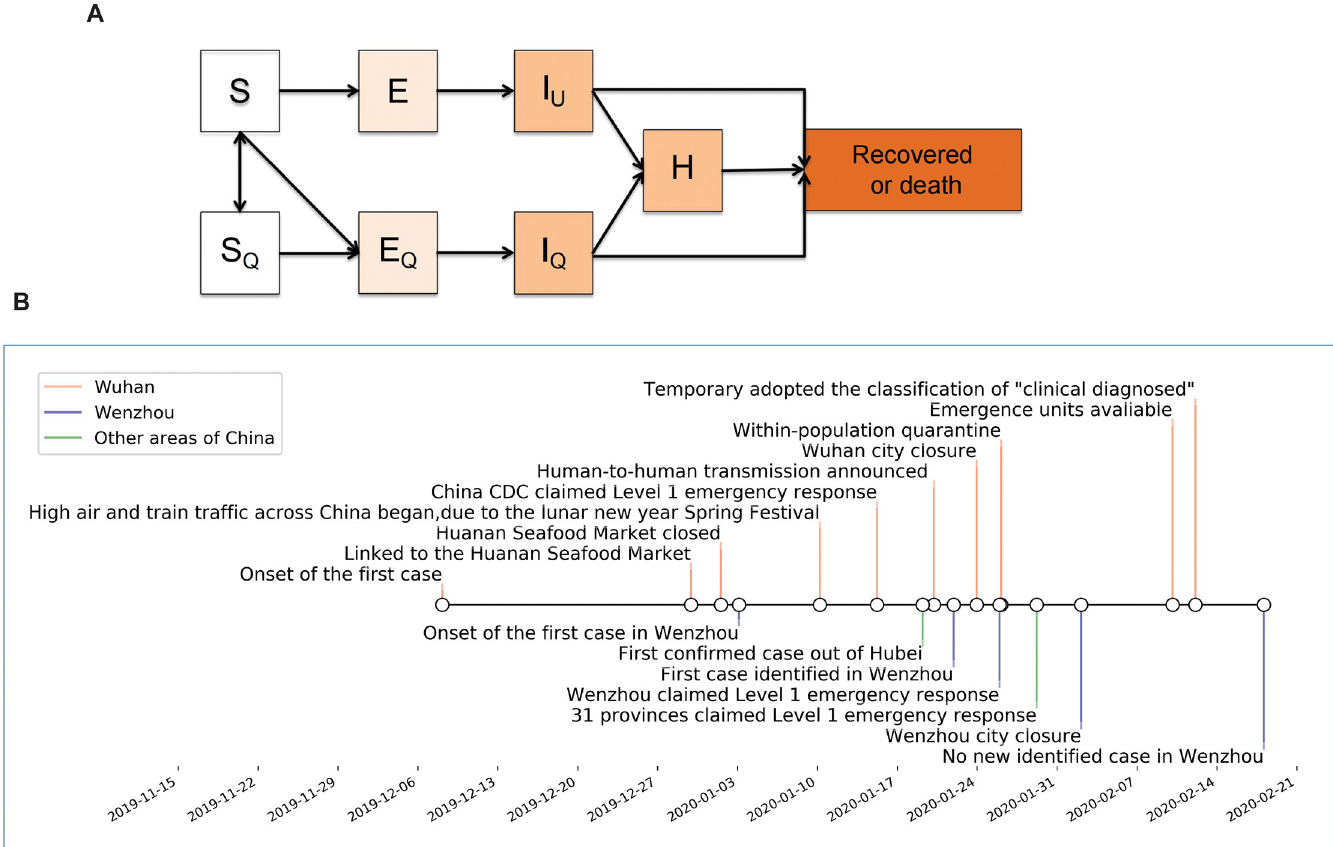
Fig 1. (A) Mathematical model for COVID-19 transmission. Susceptible individuals are infected by unidentified individuals, and become infectious themselves after an interval of incubation. Infectious individuals lose infectiousness by death, recovery, or successful isolation. No new births or deaths of other causes are considered. When quarantine started, a proportion, q , of new infections is quarantined before they become infectious. The same proportion ( q ) of susceptible individuals who have contacts with infectious persons but were not infected are also quarantined. Susceptible individuals are released from quarantine after 14 days. For simplicity, we assume that quarantined individuals are isolated and not infectious. (B) Timeline of important events occurred during COVID-19 outbreaks in Wuhan and